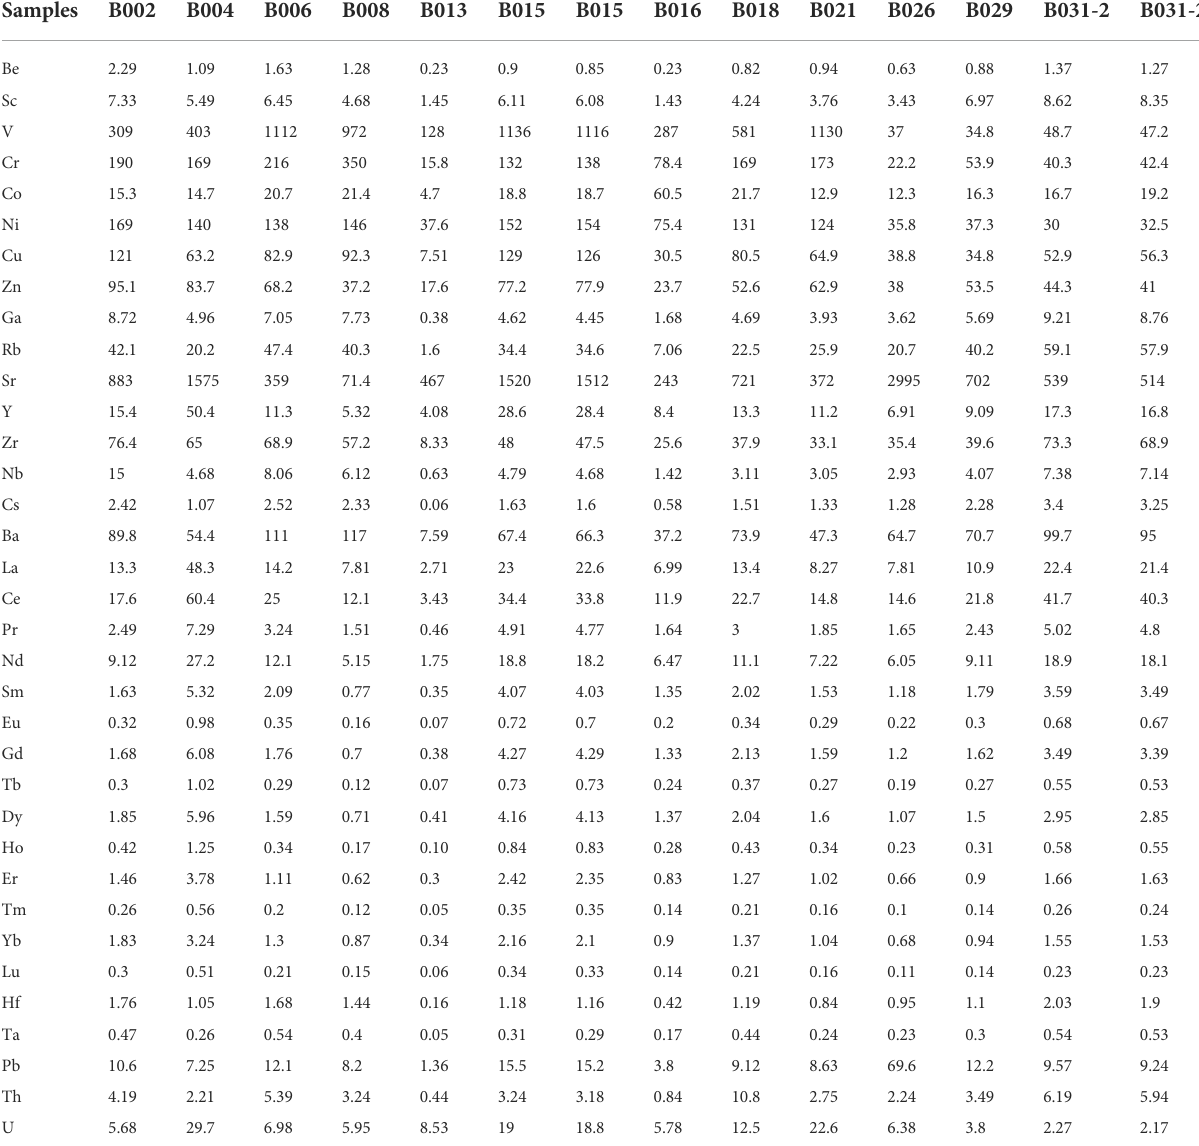
TABLE 2 Trace elements ( μ g/g) of the source rocks of Dalong and Changxing formations in northwestern Sichuan basin.